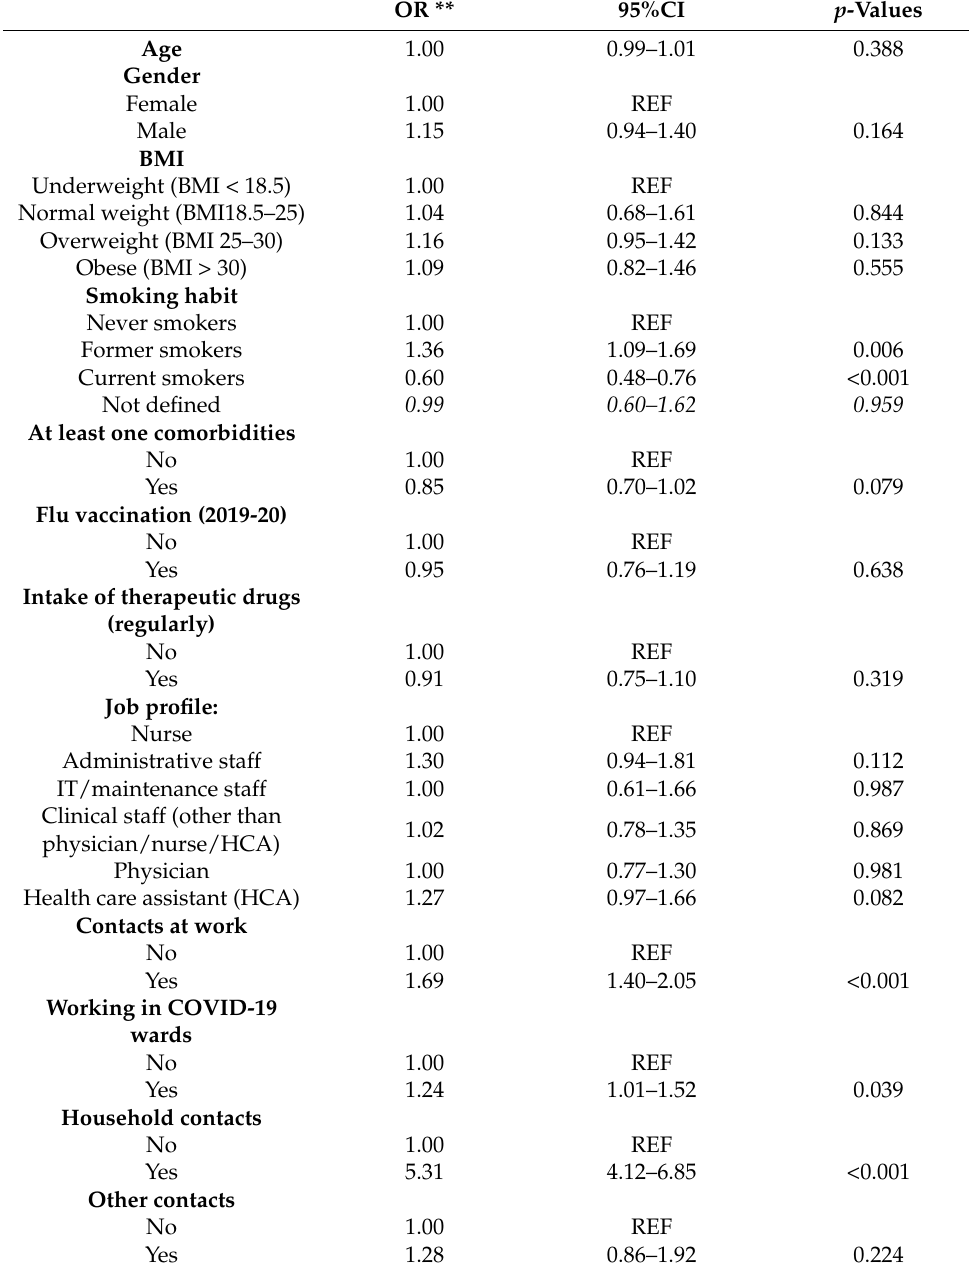
Table 2. Multivariable logistic regression model (ORs and 95%CI) for predictors of seropositivity among workers of